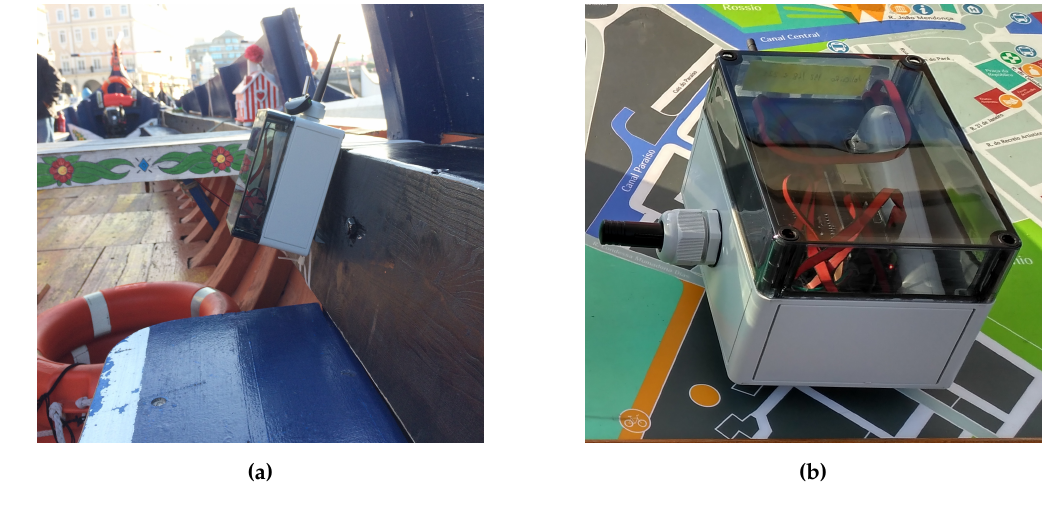
Figure 8. DCU deployment (as mobile nodes) ( a ) A mobile DCU deployed in a moliceiro; ( b ) Closer look of a mobile